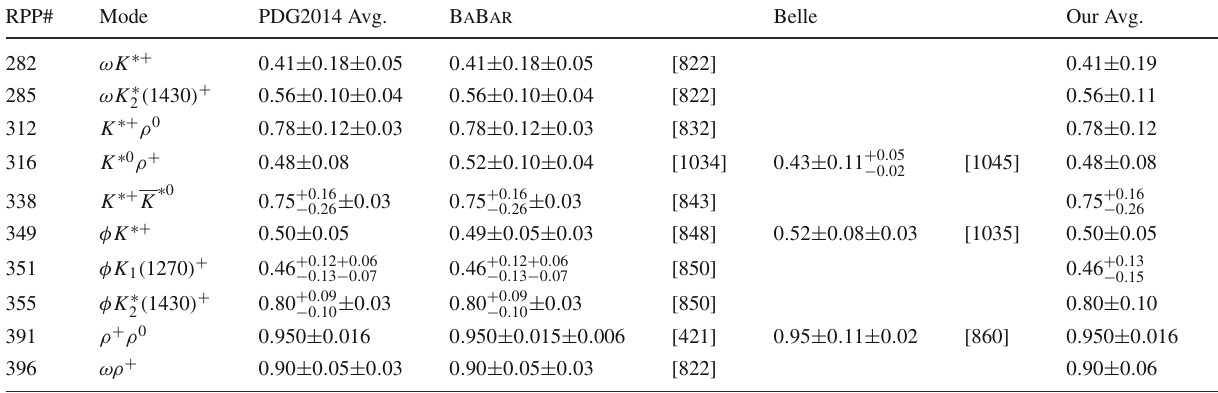
Fig. 188 A CP of most precisely measured modes Table248 Longitudinal polarizat ion fraction f L for B + decays. Where values are shown in red (blue), this indicates that they are new published (preliminary) results since